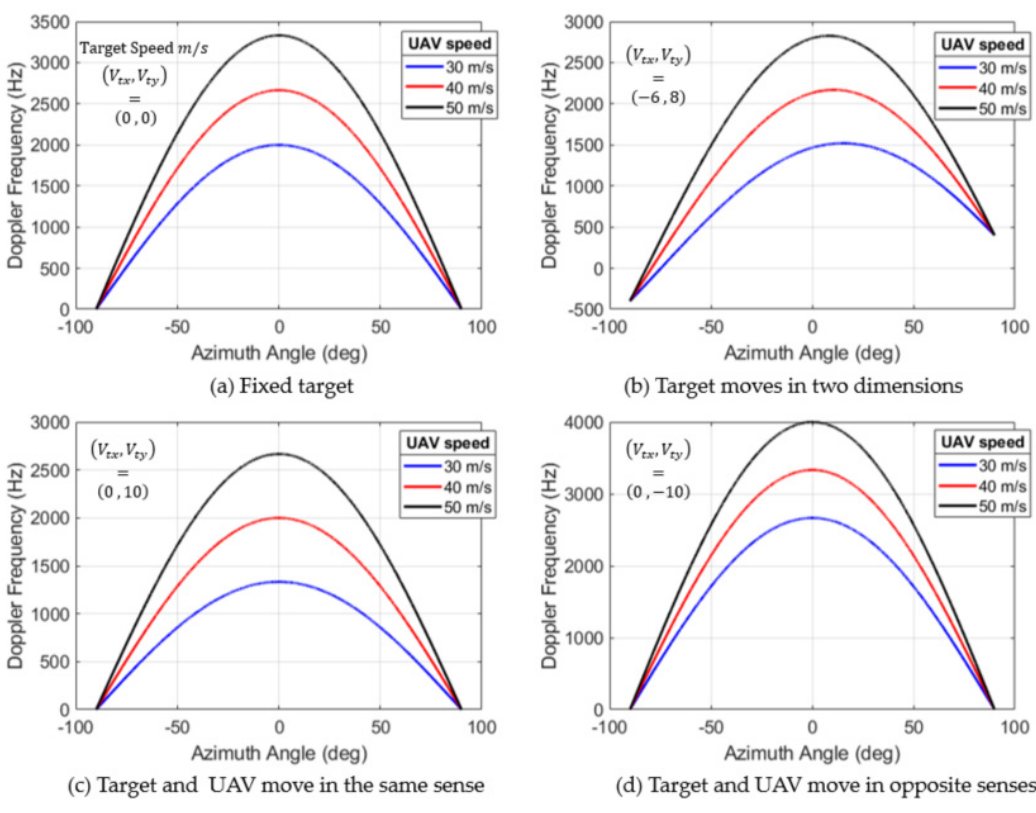
Figure 15. Doppler frequency according to relative movement between the UAV and the target.